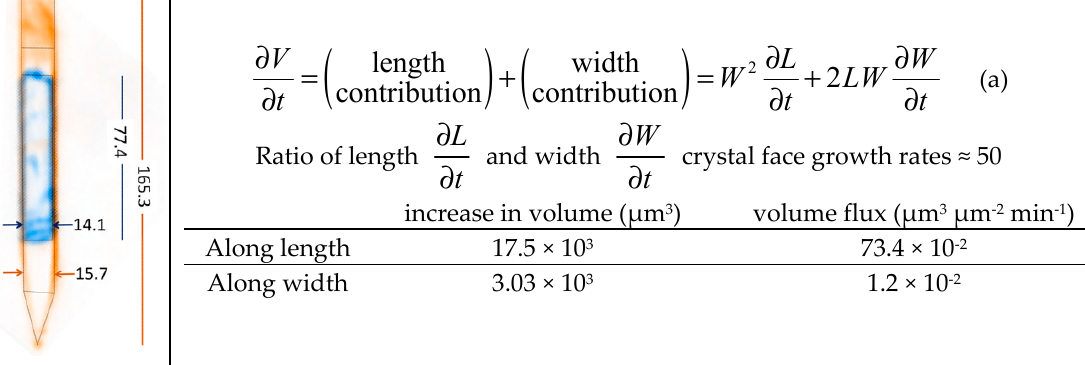
Figure A3. The crystal marked by the * in Figure A2 is shown on the left, with the edges drawn on and length and width (in μ m) indicated for both the initial (blue) and final crystal (orange). The equation for change in volume over time is shown, showing how the volume change is proportional to the length and the width squared. The table shows the change in volume for the crystal at the left.